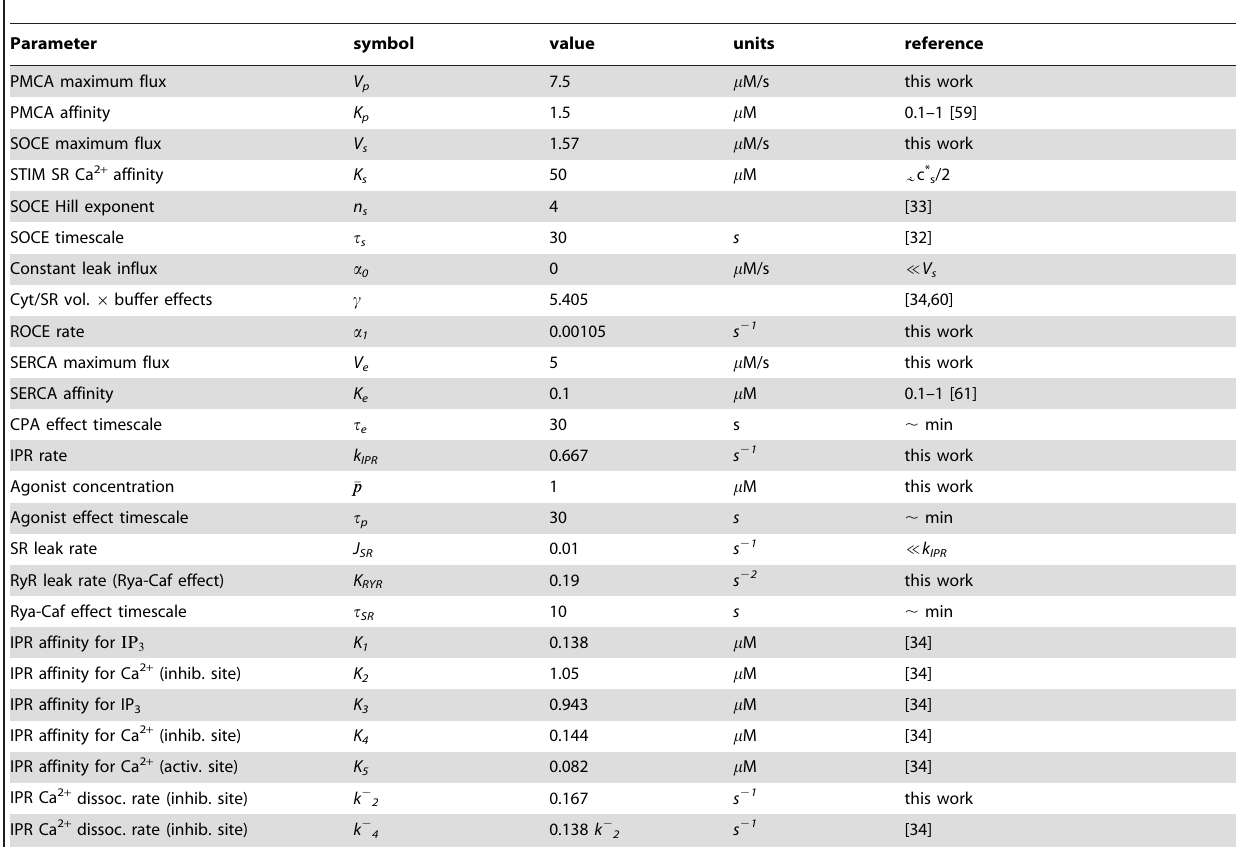
Table 1. Parameter values used in the